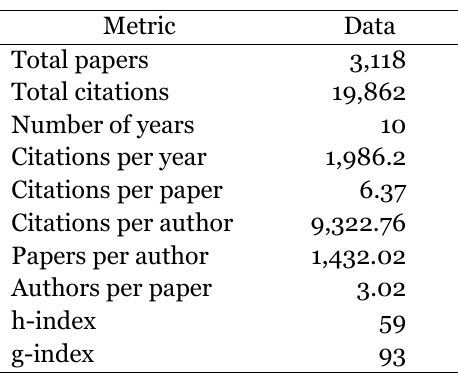
MOOCs Research Citation